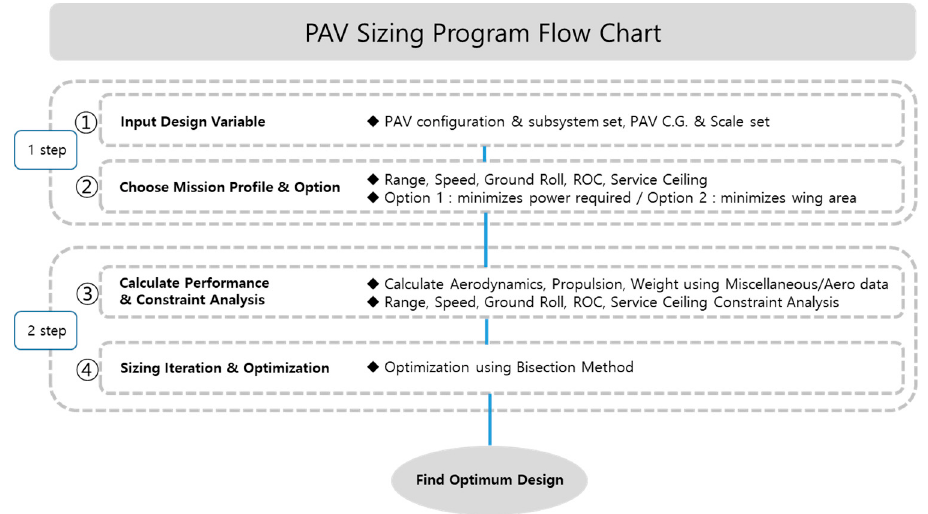
Figure 2. Personal air vehicle (PAV) sizing program flow chart. C.G., Center of Gravity; ROC, Rate of Climb.